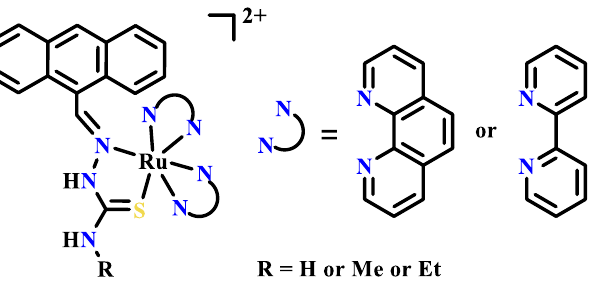
Figure 47. Ru(II) complexes of 9-anthrachydrazone with o -phenanthrene or bipyridine as the co-